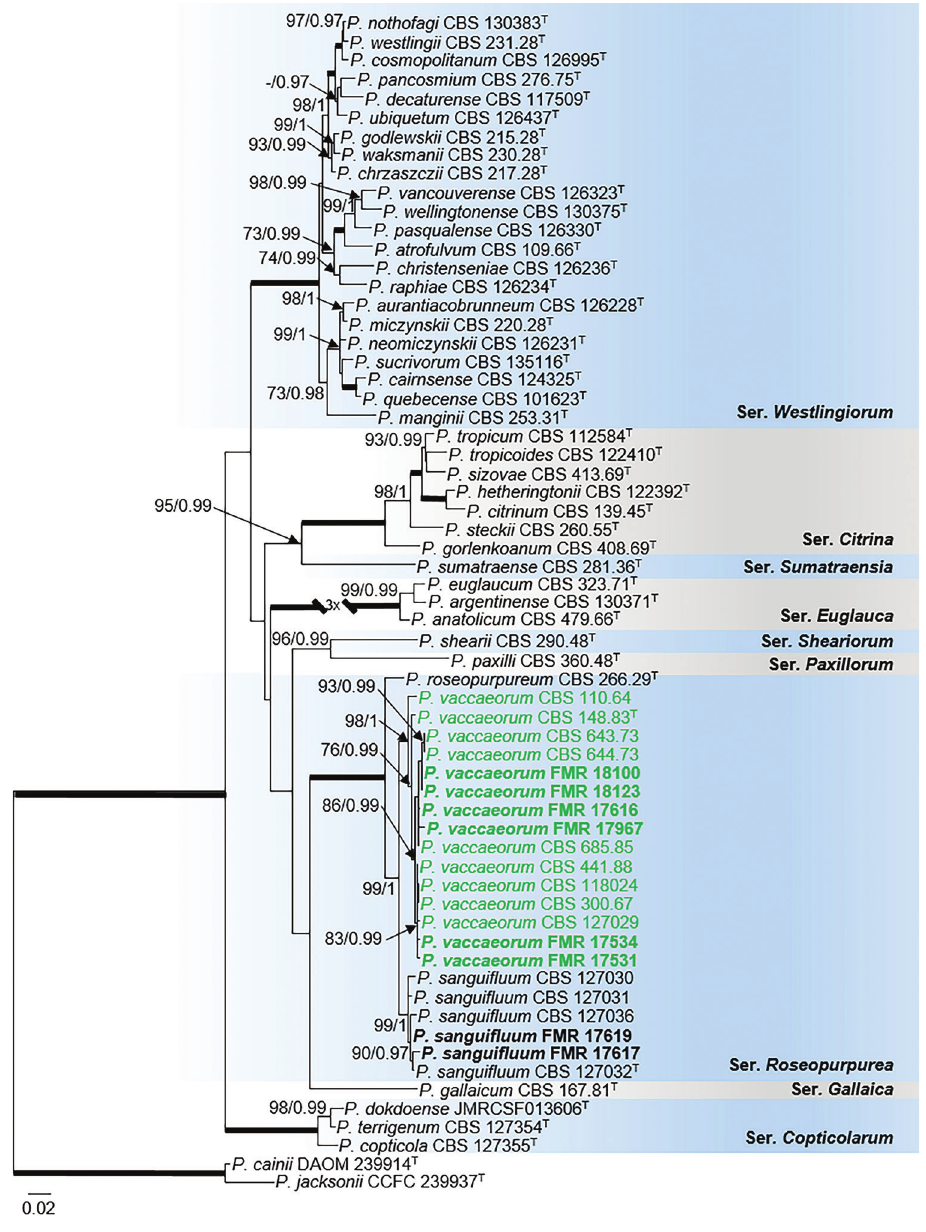
Figure 8. Phylogenetic tree of Penicillium section Citrina based on ML analysis obtained by RAxML inferred from the combined tub 2, cmdA , and ITS loci. Branch lengths are proportional to phylogenetic distance. Bootstrap support values/Bayesian posterior probability scores above 70%/0.95 are indicated on the nodes. Bold branches indicate bs/pp values 100/1. The tree is rooted to P. cainii DAOM 239914 and P. jacksonii CCFC 239937. The name in green is the resurrected species P. vaccaeorum included in this study. T = Ex-type